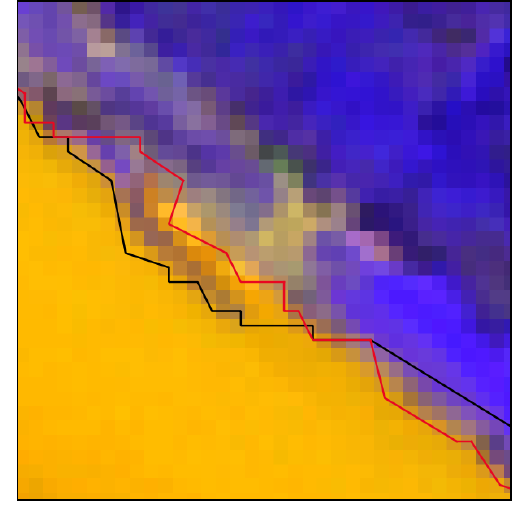
Figure 5. Edge detection differences - a peninsula